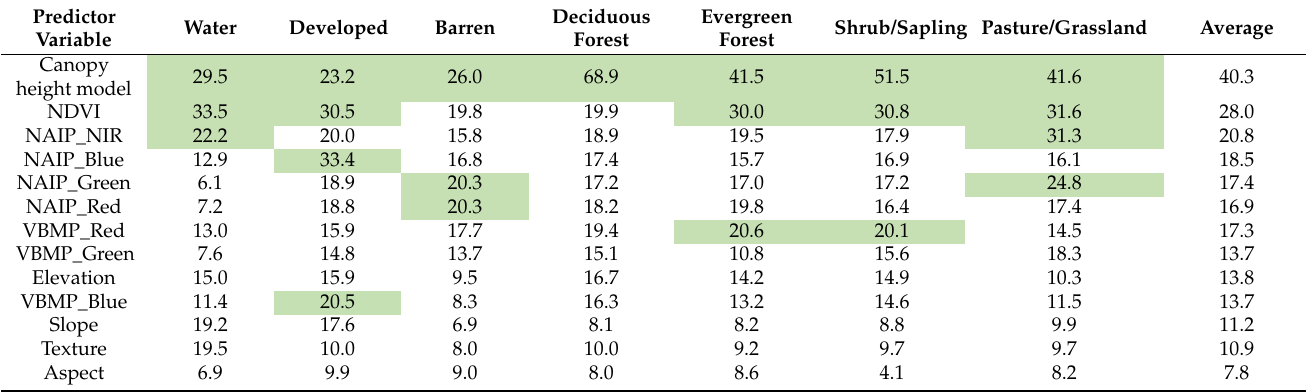
Table 2. Mean variable importance rankings from the random forest model for each predictor layer used in the land cover classification for each land cover type. The top predictor layers for each cover type (variable importance >20) are highlighted in green. All layers are described in more detail in the methods. NDVI is the Normalized Difference Vegetation Index, NAIP is the National Agricultural Imagery Project (collected in April), and VBMP is the Virginia Base Mapping Program (collected in late